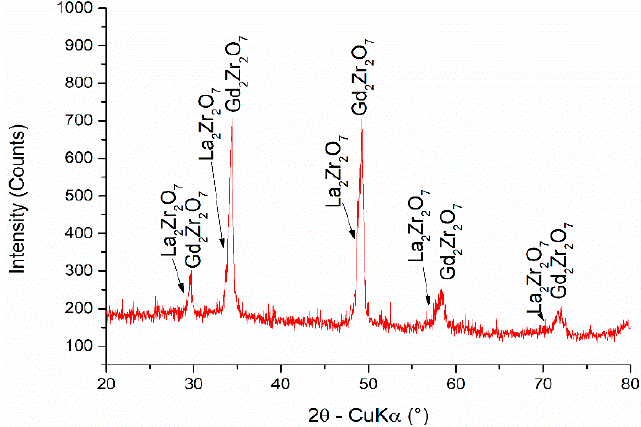
Figure 6. X-ray di ff raction spectrum obtained for Nimonic with 4 layers of material (NiCrAlY / ZrO2-RE1 / LZO / Figure 6. X-ray diffraction spectrum obtained for Nimonic with 4 layers of material (NiCrAlY/ZrO2- RE1/LZO/GZO).